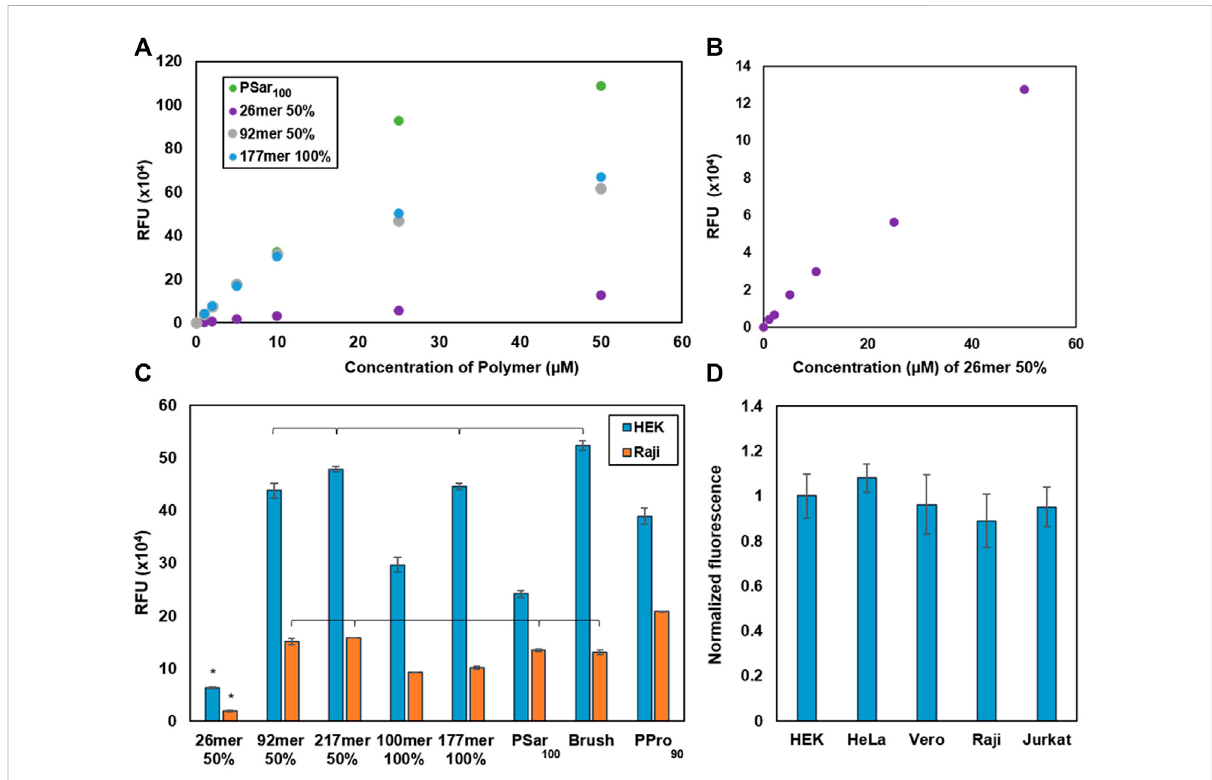
FIGURE 2 Glycocalyx engineering data to determine saturation concentrations and engineering ef fi ciency by cell type. (A) Determination of the membrane saturation concentration in HEK cells for a subset of our synMUC panel. (B) Alternate view of the data in (A) where we observed no saturation point for the lowest MW synMUC. (C) Glycocalyx engineering with a panel of synMUCs of varied composition in adherent (HEK) and suspension (Raji) cells. (D) Glycocalyx engineering with the 50% glycosylated 92mer synMUC in three adherent (HEK, HeLa, Vero) and two suspension (Raji, Jurkat) cell lines. Data has been normalized for cell volume. Data in (A – D) was collected by fl ow cytometry immediately after the glycocalyx engineering process. Data in (C,D) areaverages ofmedians calculated after gating for live,singlet cellsand associated standarderror, and were collected in duplicate. p < 0.01 is signi fi cant; brackets indicate non-signi fi